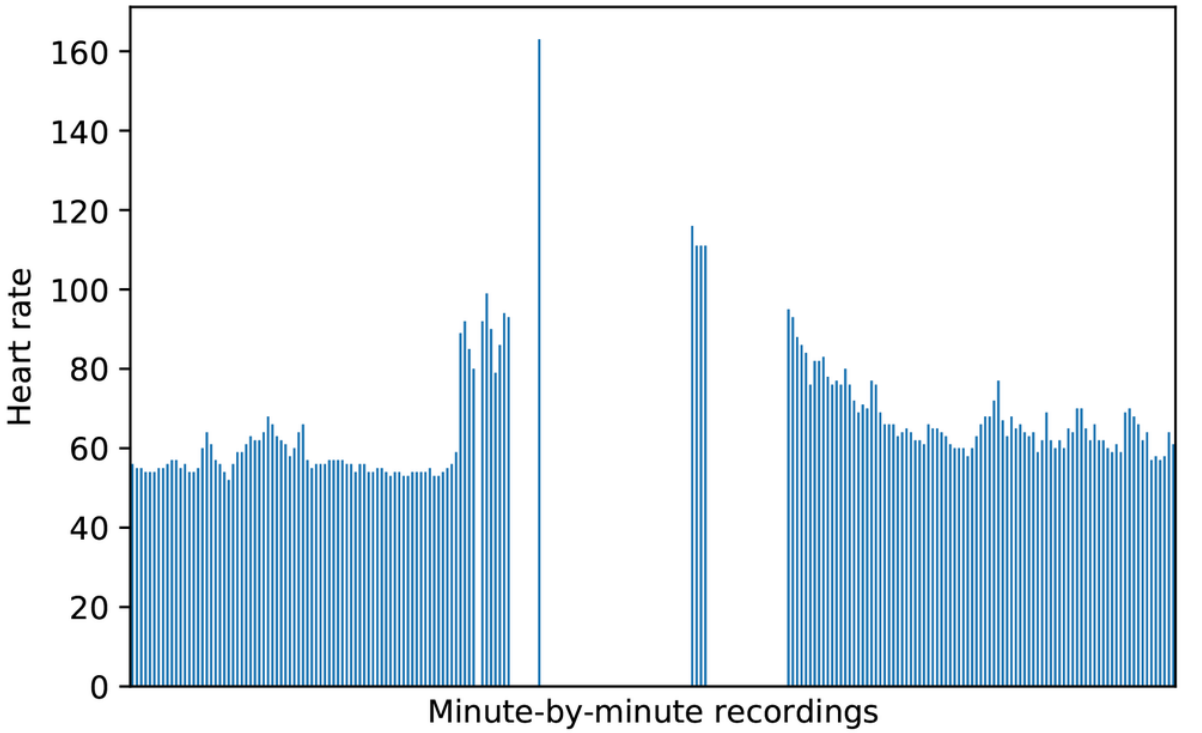
Figure 4. Minute-by-minute Fitbit recordings during a bout of elevated heart